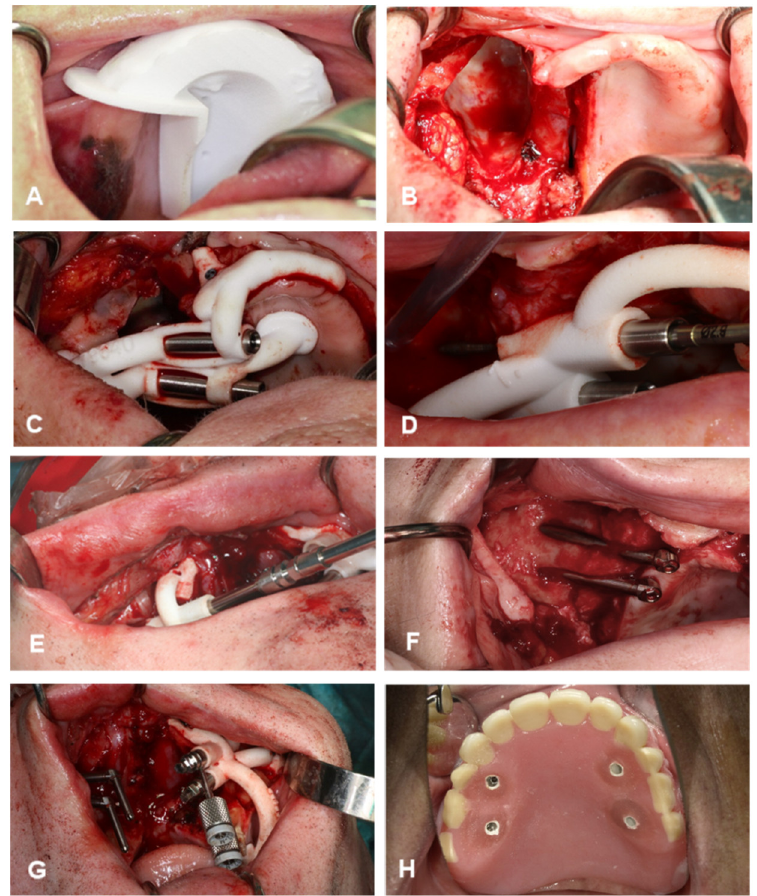
Figure 3. Surgical procedure. ( A , B ), maxillectomy according to the preplanned, individually de- signed cutting guides. ( C ) Drill guide seated with a tight fit and fixated with osteosynthesis screws. ( D ) Zygomatic drill inserted in the guide to perform the preplanned drill. ( E ) Insertion of zygomatic implant into the bone until the fixture mount contacts the reference stop on the guide. ( F ) View of zygomatic implant positions after removing the guide. ( G ) Final screw direction of the fixture mounts, which correspond exactly with the abutment positions. ( H ) Implant-retained obturator prosthesis immediately fixated with non-engaging prosthetic cylinders mounted into the prepared slots with a light-curing denture resin.